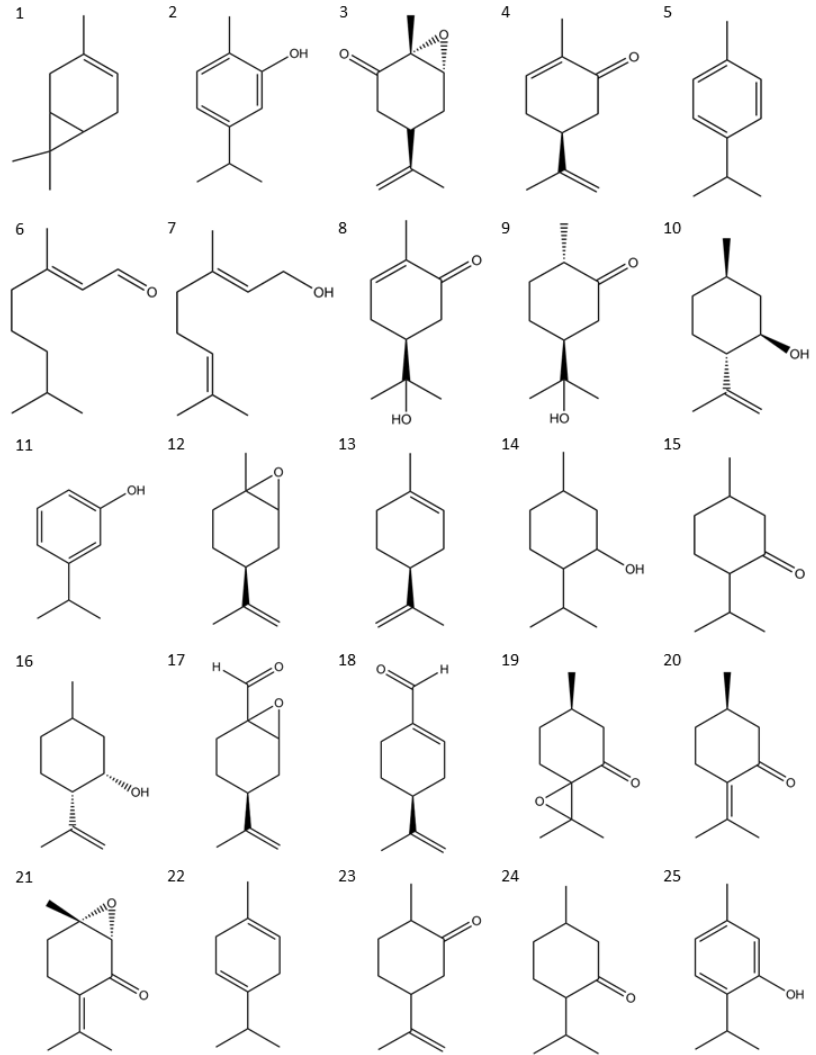
Figure 1. Chemical structure of terpenes and derivates evaluated. ( 1 ) 3-Carene, ( 2 ) Carvacrol, ( 3 ) Carvone epoxide, ( 4 ) Carvone, ( 5 ) p-Cymene, ( 6 ) Geranial, ( 7 ) Geraniol, ( 8 ) Hydrocarvone, ( 9 ) Hydrodihydrocarvone, ( 10 ) Isopulegol, ( 11 ) 3-Isopropylphenol, ( 12 ) Limonene epoxide, ( 13 ) Limonene, ( 14 ) Menthol, ( 15 ) Mentone, ( 16 ) Neoisopulegol, ( 17 ) Perillaldehyde epoxide, ( 18 ) Perillaldehyde, ( 19 ) Pulegone epoxide, ( 20 ) Pulegone, ( 21 ) Rotundifolone, ( 22 ) γ -Terpinene, ( 23 ) Trans-Dihydrocarvone, ( 24 ) Trans-Isopulegone, ( 25 ) Thymol.